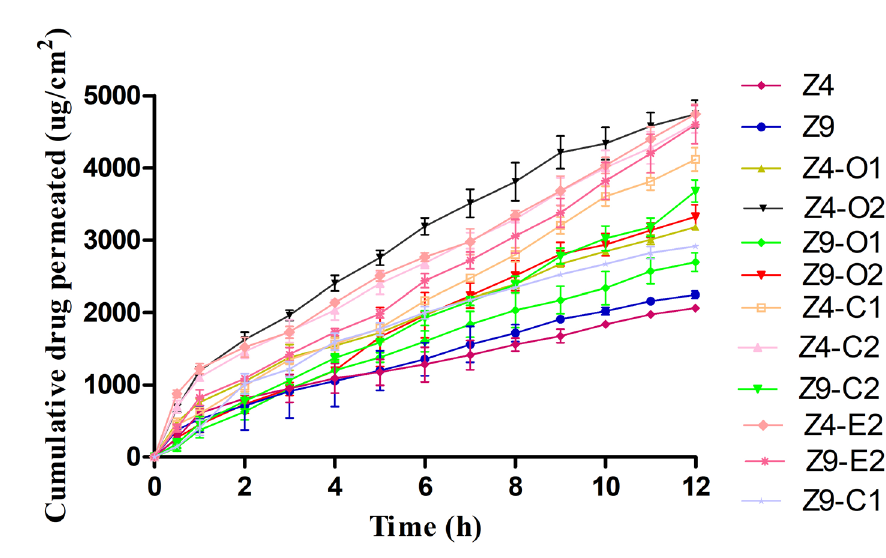
FIGURE 6 - Ex vivo cumulative drug release from transdermal patches containing permeation enhancers (n=3).